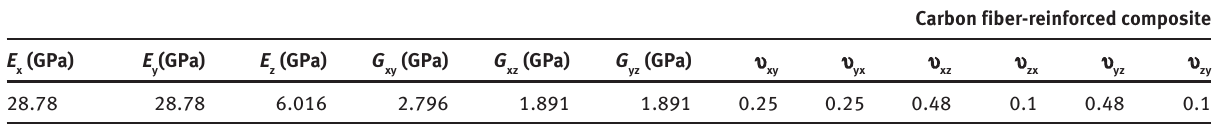
Table 4: Numerically obtained material constants (carbon fiber-reinforced composite).